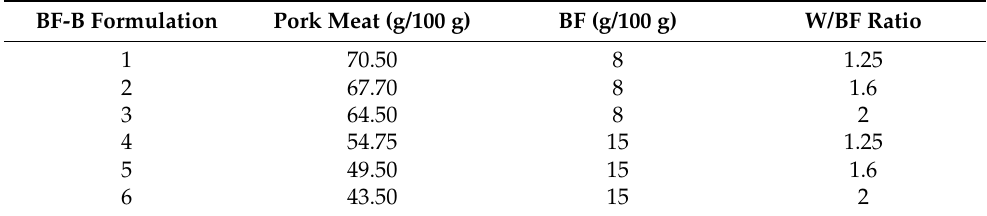
Table 1. Pork meat, bean flour (BF), and water/bean flour ratio (W/BF) to prepare 100 g of raw bean flour pork burgers